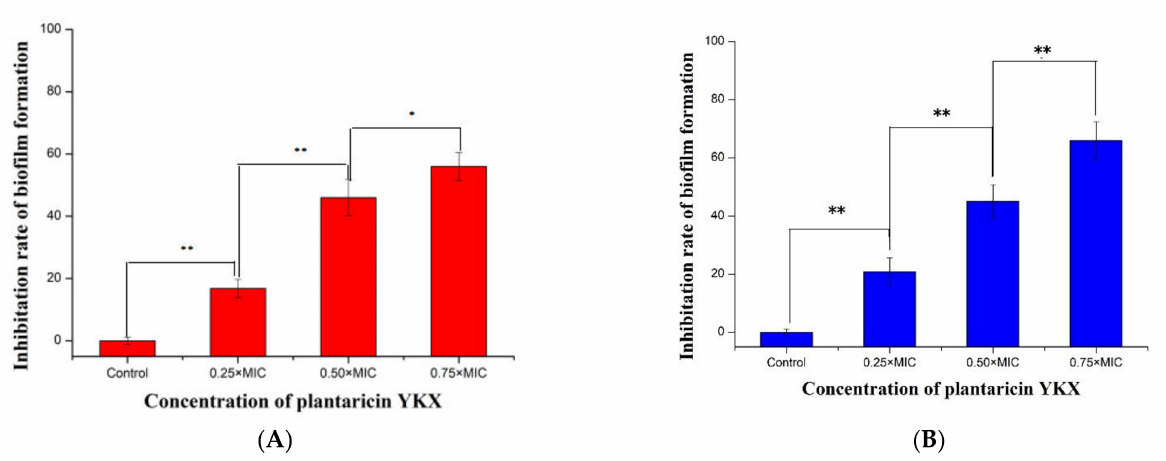
Figure 5. Effect of plantaricin YKX on S. aureus biofilm formation. S. aureus ATCC 25923 ( A ) and S. aureus CMCC 26570 ( B ). * significant. p < 0.05; ** highly significant. p <